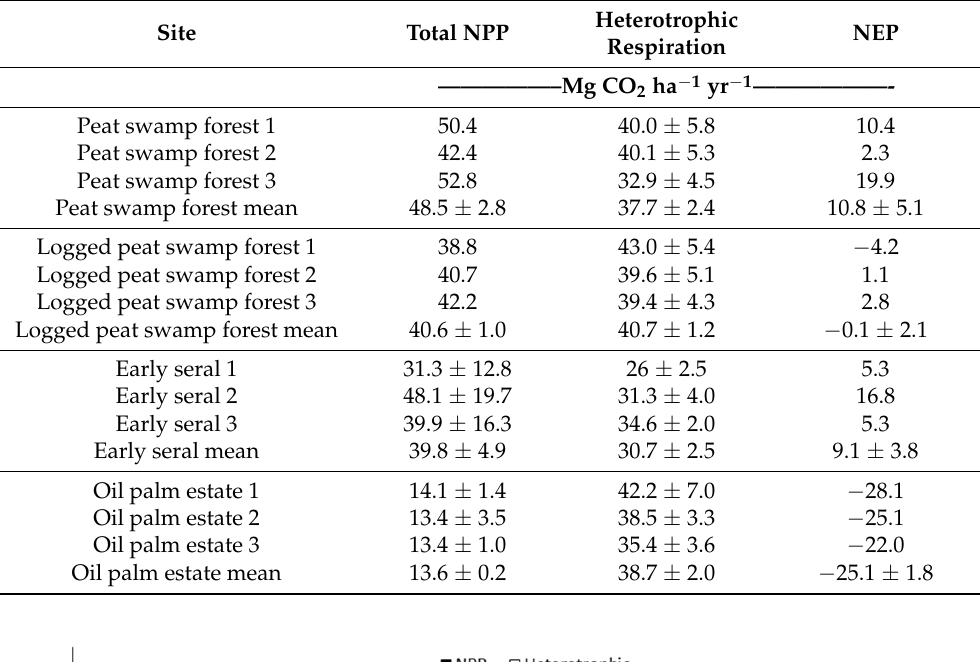
Table 4. Net primary production (NPP), net ecosystem production (NEP), and heterotrophic respiration in intact and logged peat forest, early seral, and oil palm estate were reported as mean ± SE whenever possible.